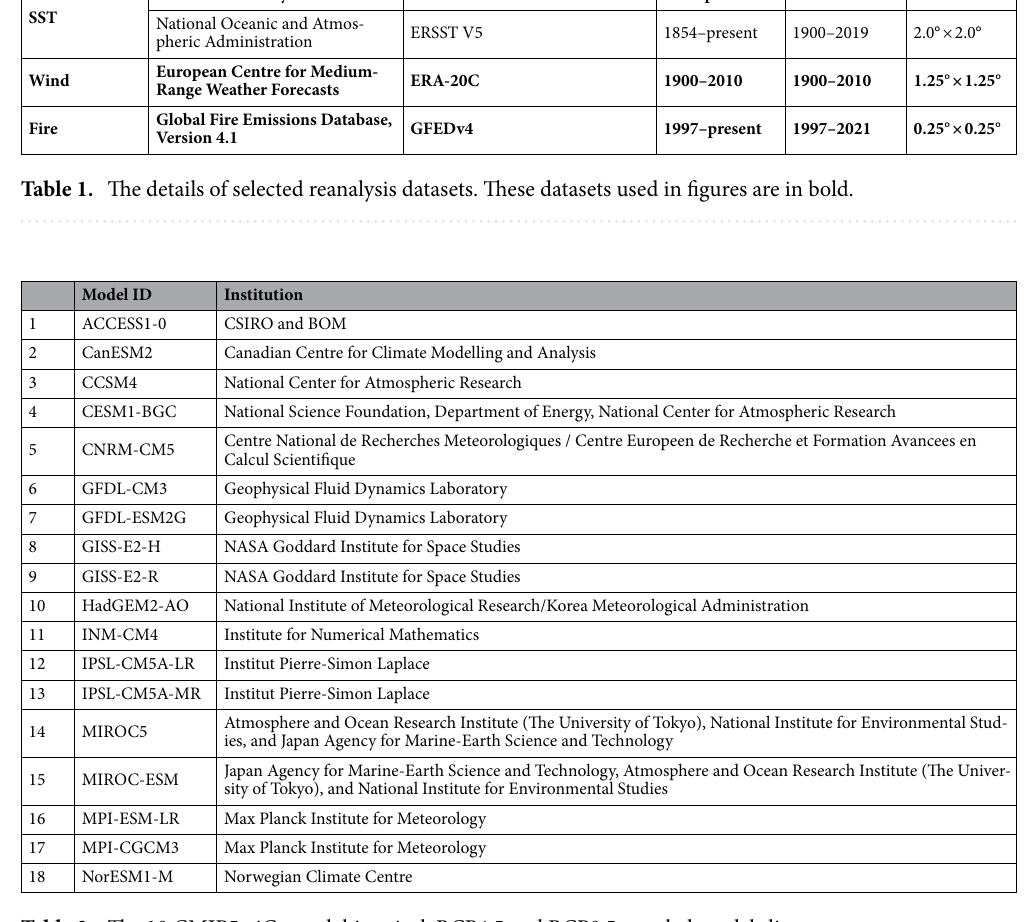
Table 2. The 18 CMIP5 piControl, historical, RCP4.5 and RCP8.5 coupled models list.